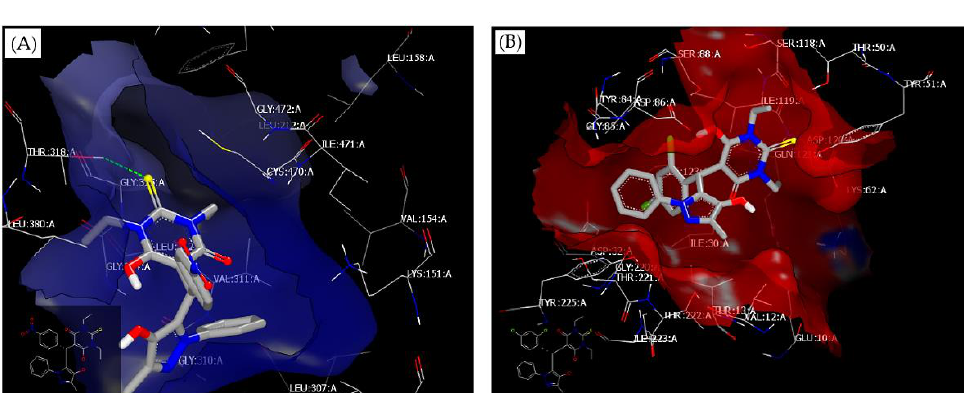
Figure 8. Ligand – receptor interaction profiles by molecular docking. ( A ) Interactions between 4WMZ and 61h , and ( B ) interactions between 4WMZ and 61l . Image adapted from Elshaier et al. [65].